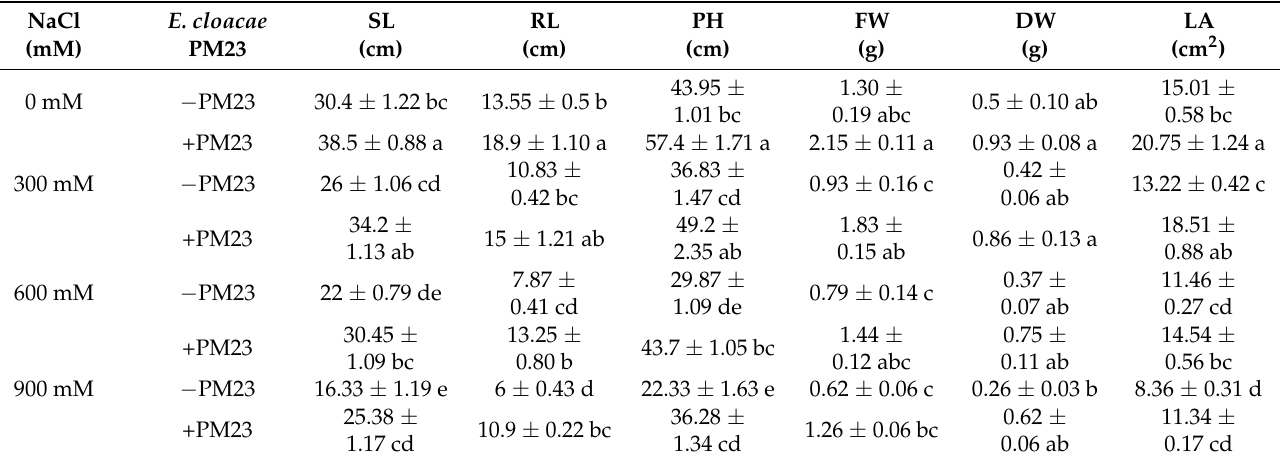
Table 2. Maize growth, biomass and leaf surface area in presence and absence of Enterobacter cloacae PM23 under salinity